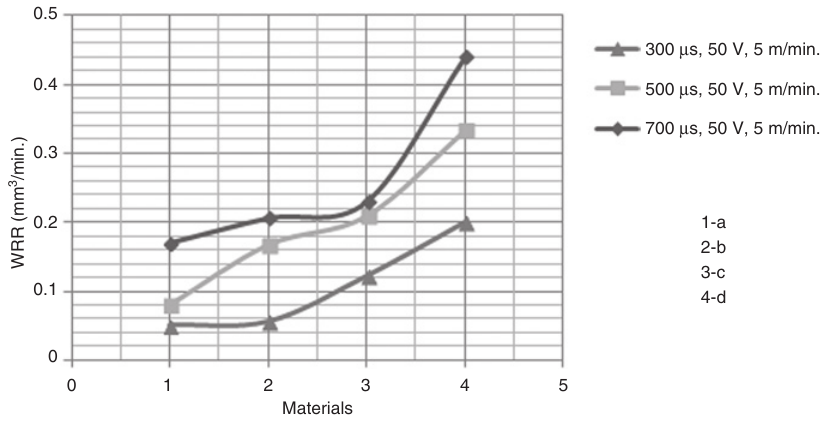
Figure 13 Effect of pulse duration: wire remove